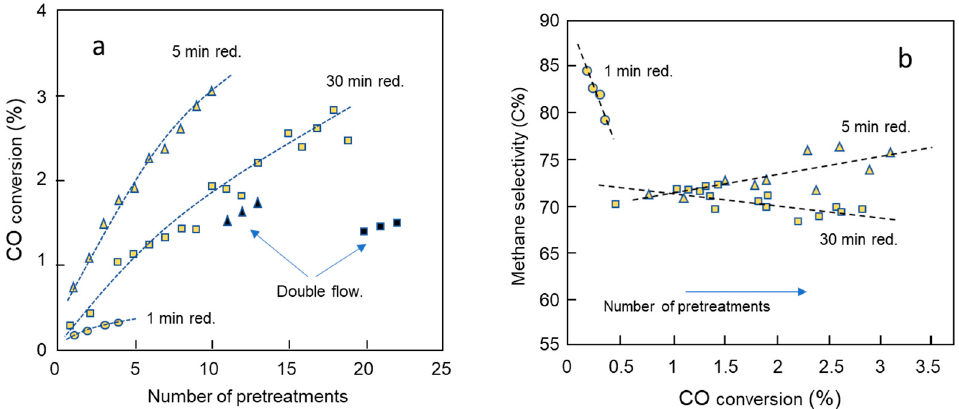
Figure 2. ( a ) CO conversion as a function of number of pretreatments. ( b ) Methane selectivity as a function of CO conversion. Conditions: fresh foil for each reduction time of 1, 5, or 30 min; calcination and reduction at 300 °C; FTS at 220 °C and 1 bar; open symbols: flow, 3 Nml/min; closed symbols: 6 Nml/min; TOS for each FT synthesis: 70 min.